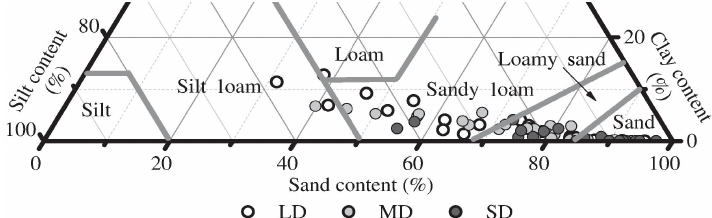
Figure 4. Particle size distributions of lightly degraded (LD), moderately degraded (MD) and severely degraded (SD) soil samples. Textural classes corresponding to particle size distributions observed in these soils are bounded by bold grey lines (e.g. loam,